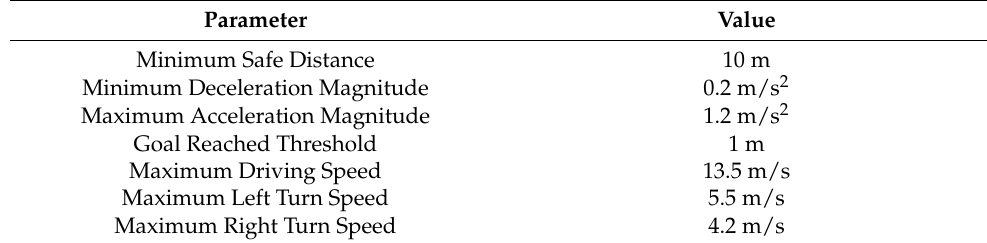
Table 3. Parameters used to constrain driving